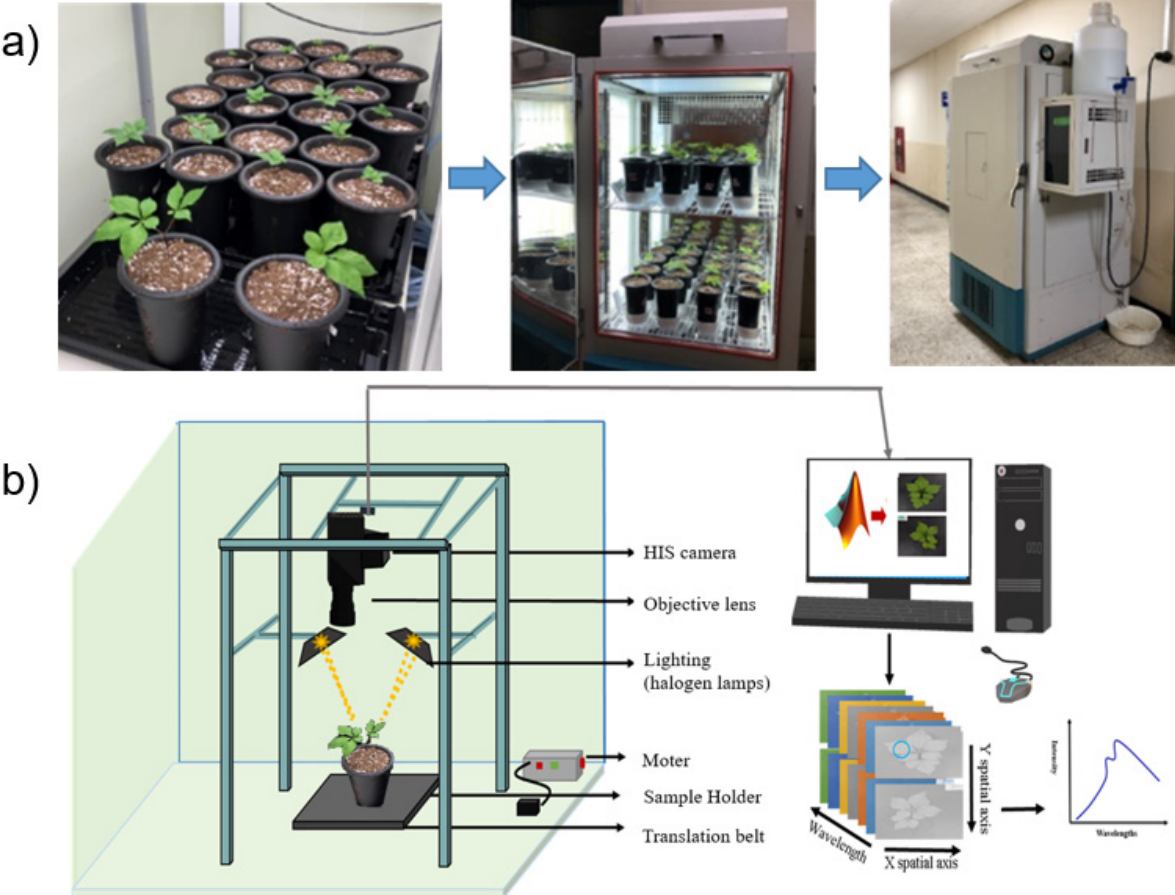
Figure 1. Heat stress treatment of ginseng plants in the growth chamber ( a ) and HSI system components ( b ).